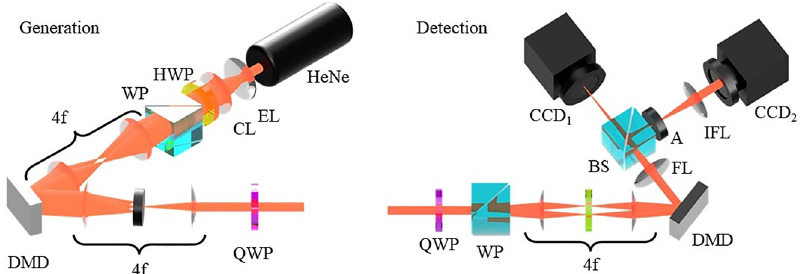
Figure 2: (Left) Diagram showing the arrangement used to generate arbitrary vector beams using a Wollaston prism to separate orthogonal circular polarizations and a DMD to recombine these – post modulation. (Right) Diagram showing the arrangement used to characterize arbitrary vector fields making use of a Wollaston prism to separate and a DMD to recombine orthogonal polarization components, with a linear polarizer to allow for interference of orthogonally polarized components. Abbreviations: HeNe – helium neon laser, EL – expansion lens, CL – collimation lens, HWP – half-wave plate, WP – Wollaston prism, BS – beam splitter, LP – linear polarizer, DMD –